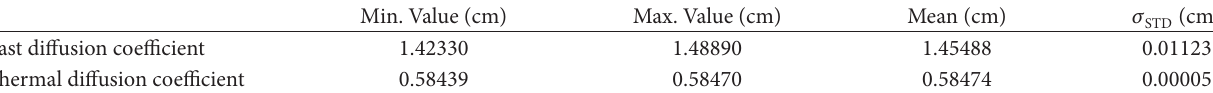
T 9: Uncertainty analysis of homogenized macroscopic cross-sections (thermal group, ENDF/B-VII.1). Parameter Min. value (1/cm) Max. value (1/cm) Mean (1/cm) NUSIGF 0.136721 0.13750 0.13710 Absorption 0.08014 0.08103 0.08077 Scattering (in-group) 0.99708 0.99742 0.99732 Scattering (out-group) 0 0 0 0 T 10: Uncertainty analysis of fast and thermal diffusion coefficients (ENDF/B-VII.1). Min. Value (cm) Max. Value (cm)